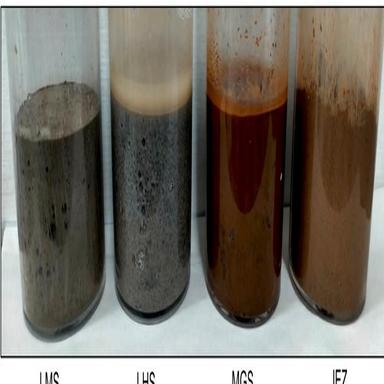
Photo of the saturated regolith simulant samples.